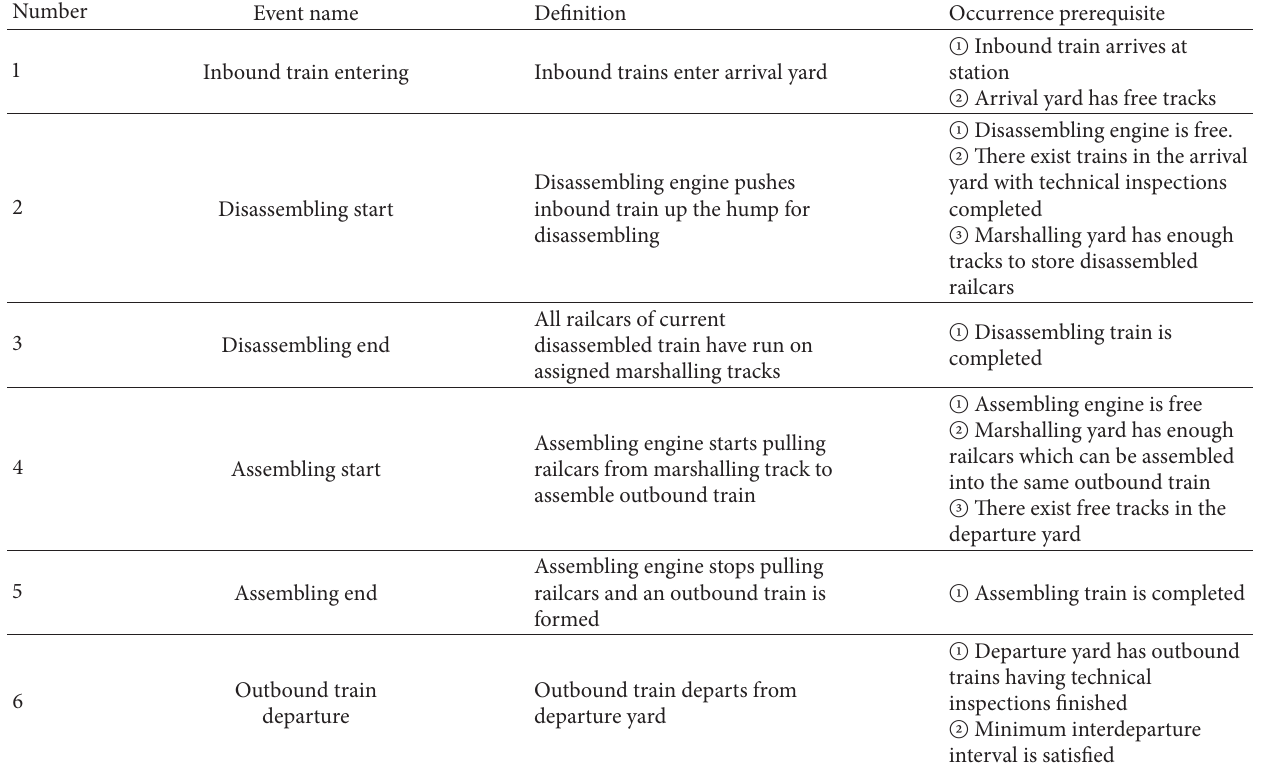
Table 1: Events’ definition and occurrence